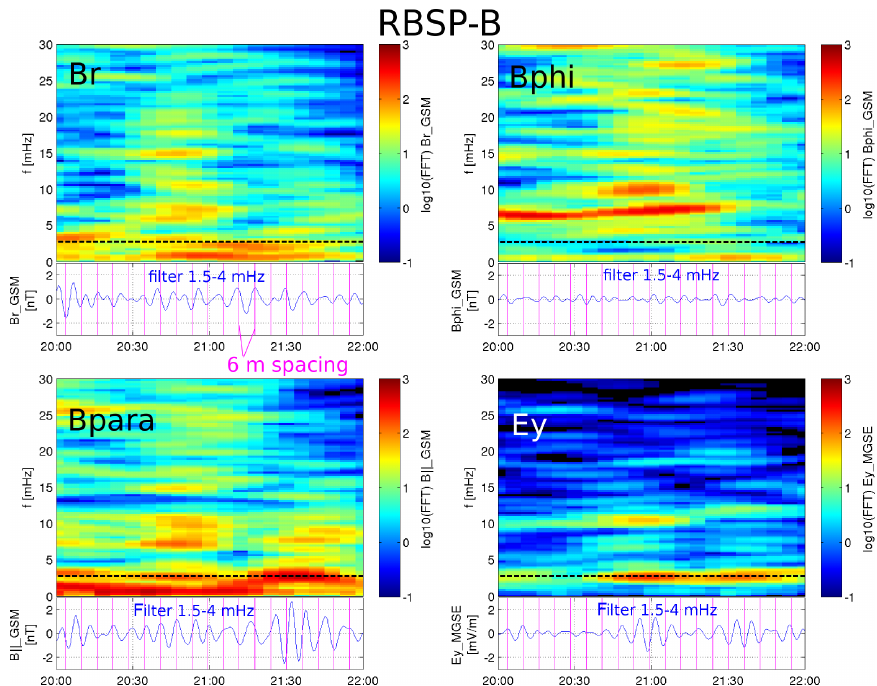
Figure 4. Summary of the Pc4-5 ULF wave frequency spectra from Van Allen Probe B during the time interval of interest (20:00–22:00UT). Dynamic spectrograms are shown for the three components of the magnetic field (in the mean field-aligned, GSM coordinates) along with the y component of the electric field in MGSE coordinate. Band-pass filtered time series (1.5–4mHz) are shown below each dynamic spectrogram. The black dashed lines indicate the frequency at ∼ 2.6mHz.